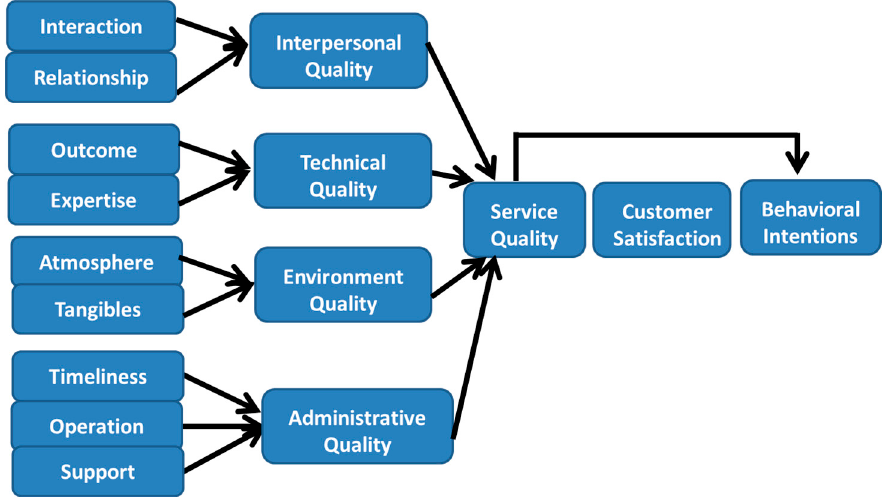
Figure 4. The concept of hierarchical model of health service quality